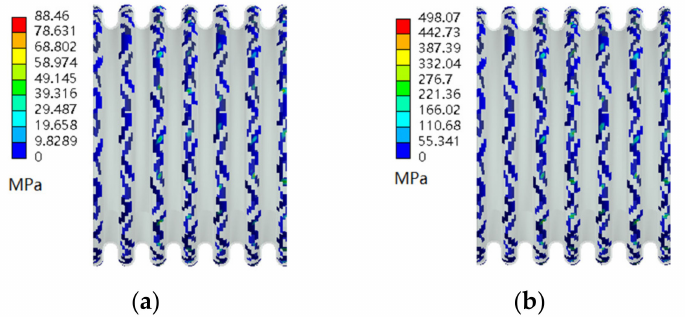
Figure 13. Frictional stress and contact pressure of the braided corrugated hose: ( a ) Frictional stress, ( b ) Contact